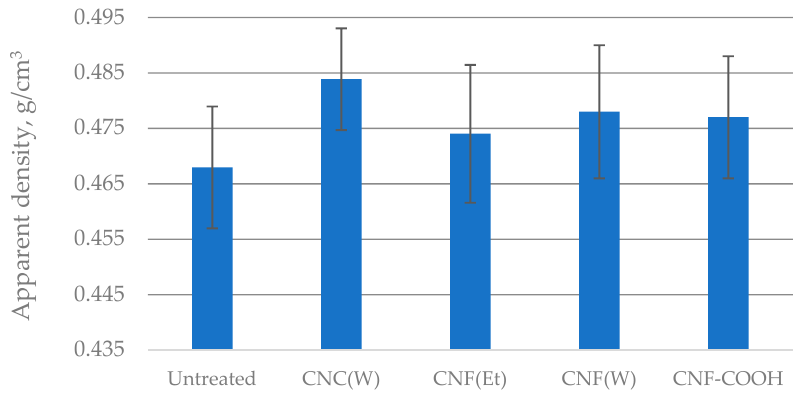
Figure 7. The apparent density of coated WBP.